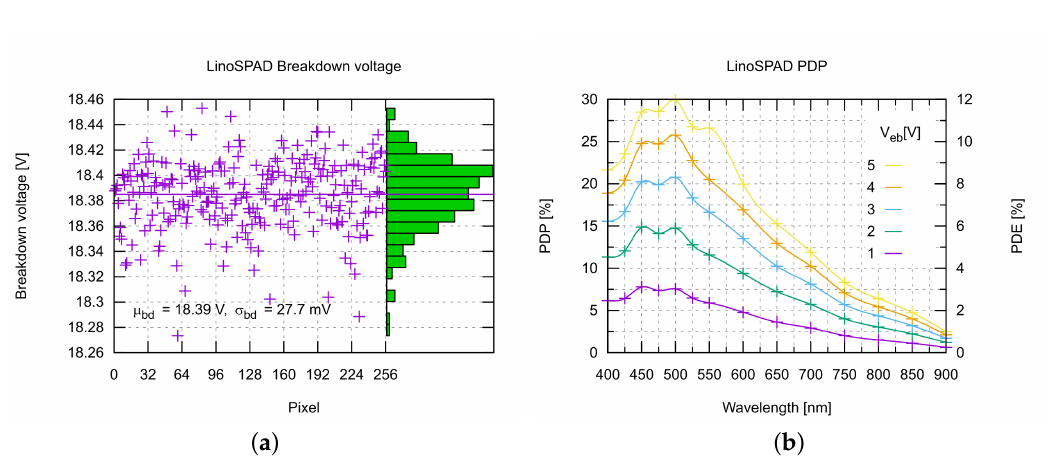
Figure 6. ( a ) Per-pixel breakdown voltage obtained using the excess noise method. In-chip standard deviation is typically below 100 mV; ( b ) Photon-detection probability and efficiency (PDP, PDE) for LinoSPAD in the wavelength range 400–900 nm measured for increasing excess bias using an integrating sphere and reference